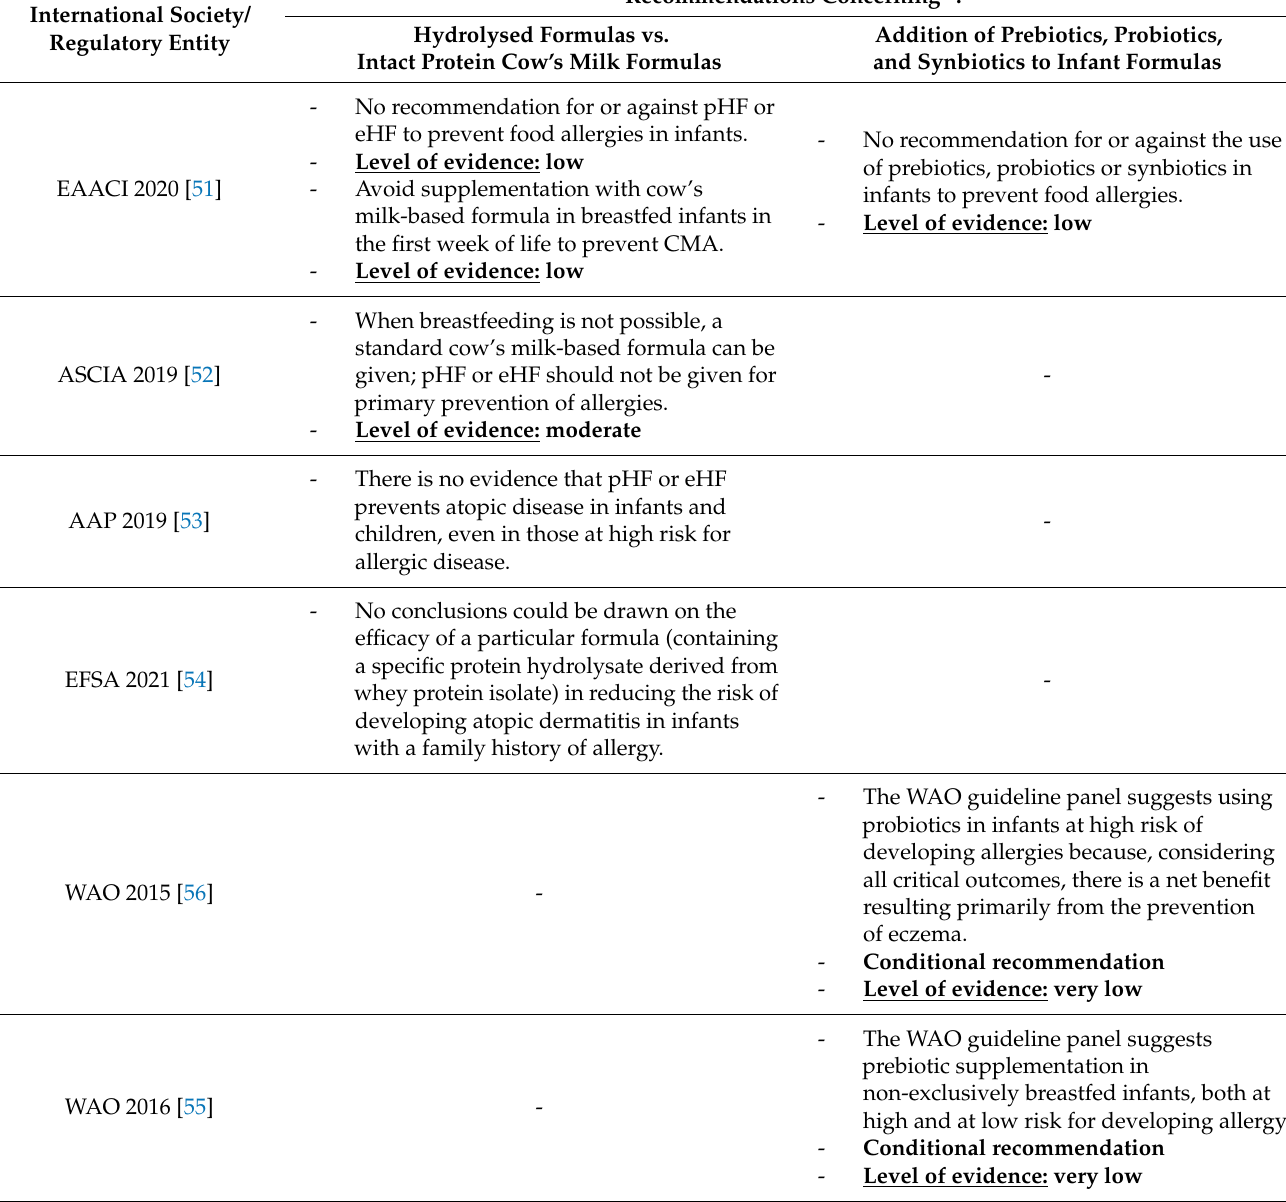
Table 1. Recommendations made by paediatrics and gastroenterology international societies and regulatory entities in the context of primary allergy